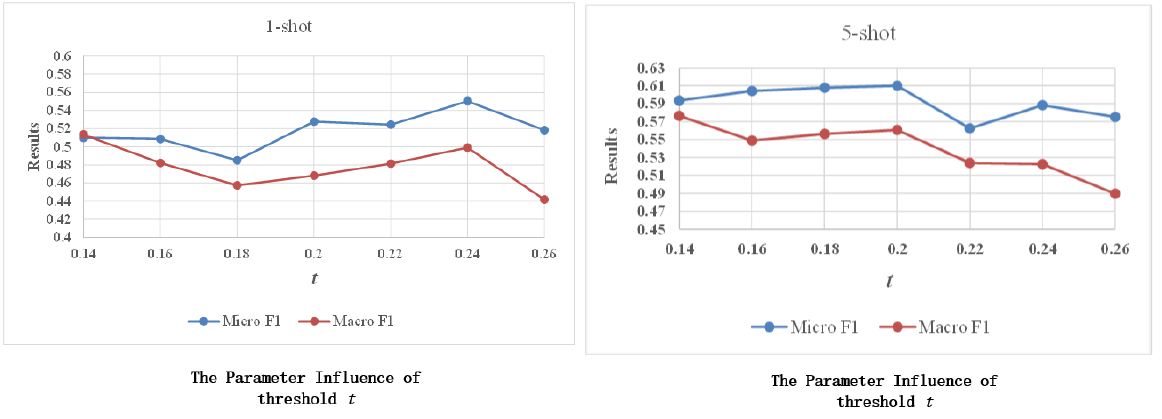
Figure 4. Effects of threshold t on two